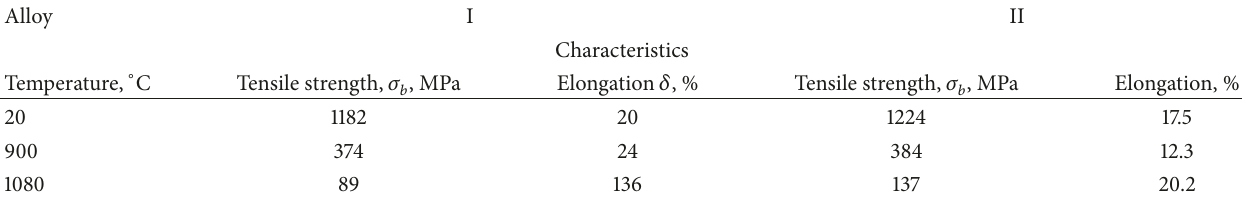
Table 2: Mechanical properties at different temperatures of alloys I and